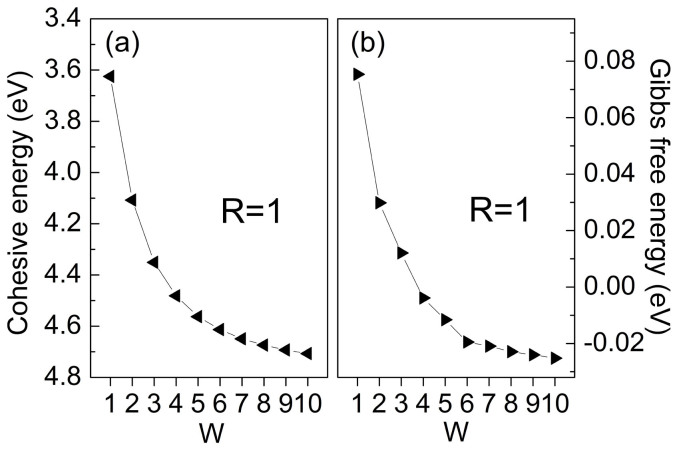
Per-atom cohesive energy Ecoh (a) and Gibbs free energy δG (b) in SNMs as a function of W with R = 1.